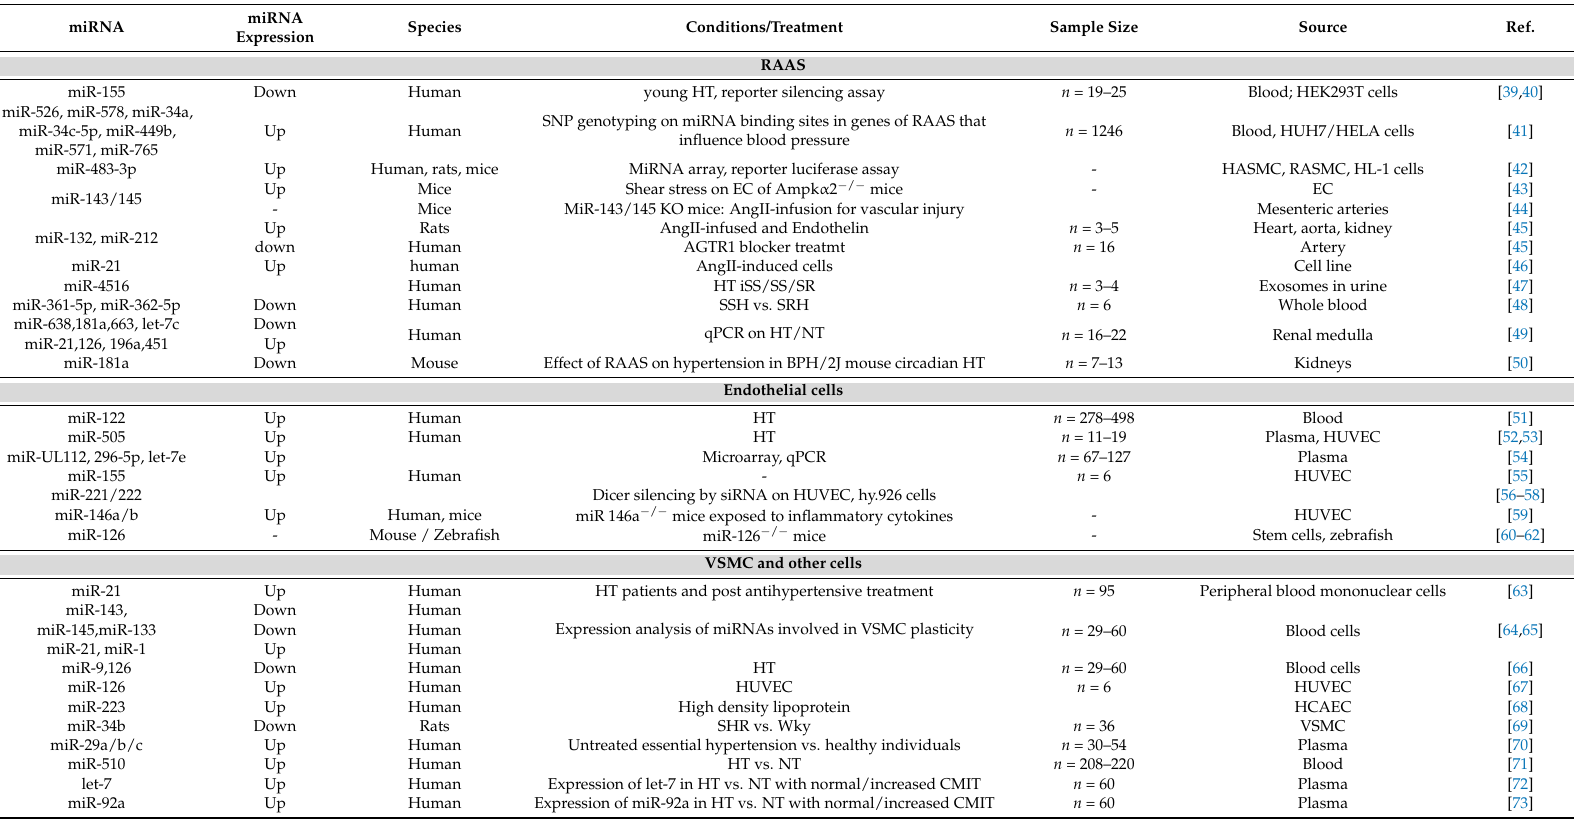
Table 1. miRNAs associated with